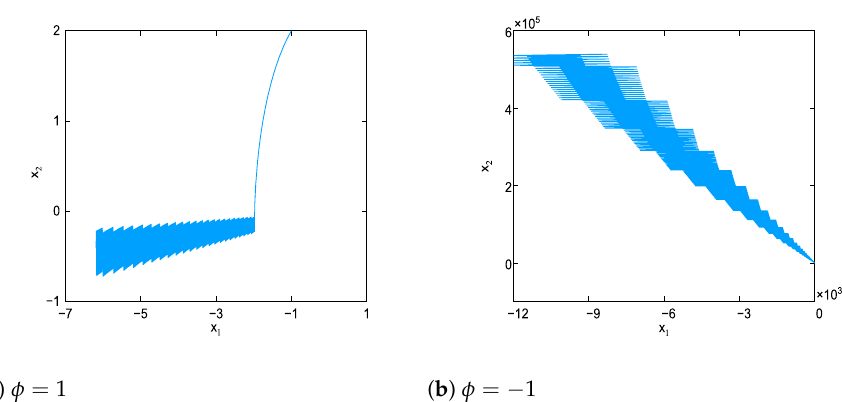
Figure 3. The phase diagrams of system (8) under the switching rule (6).